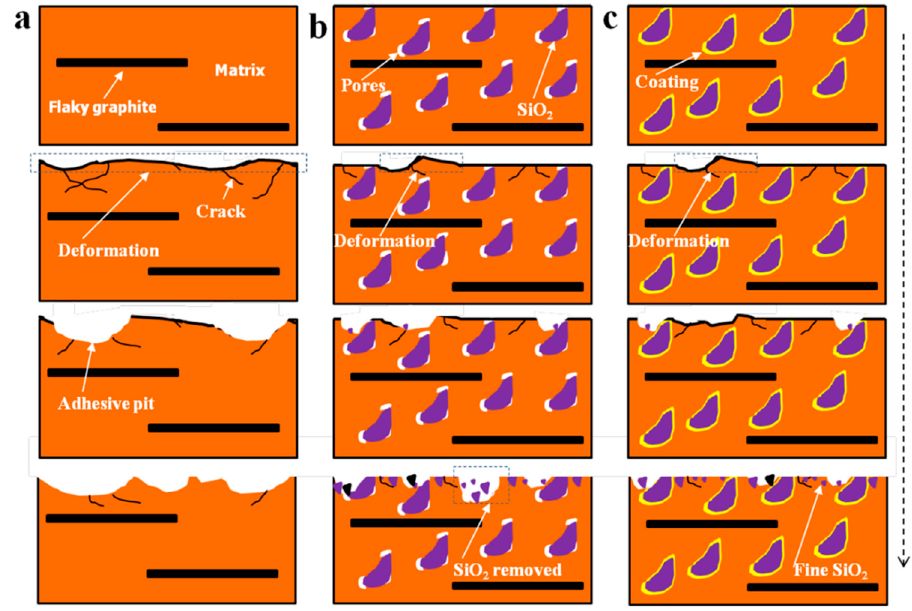
Figure 8. Schematic diagram of the wear process of the composites: ( a ) 0S; ( b ) 3S; ( c ) 3S-Cu.